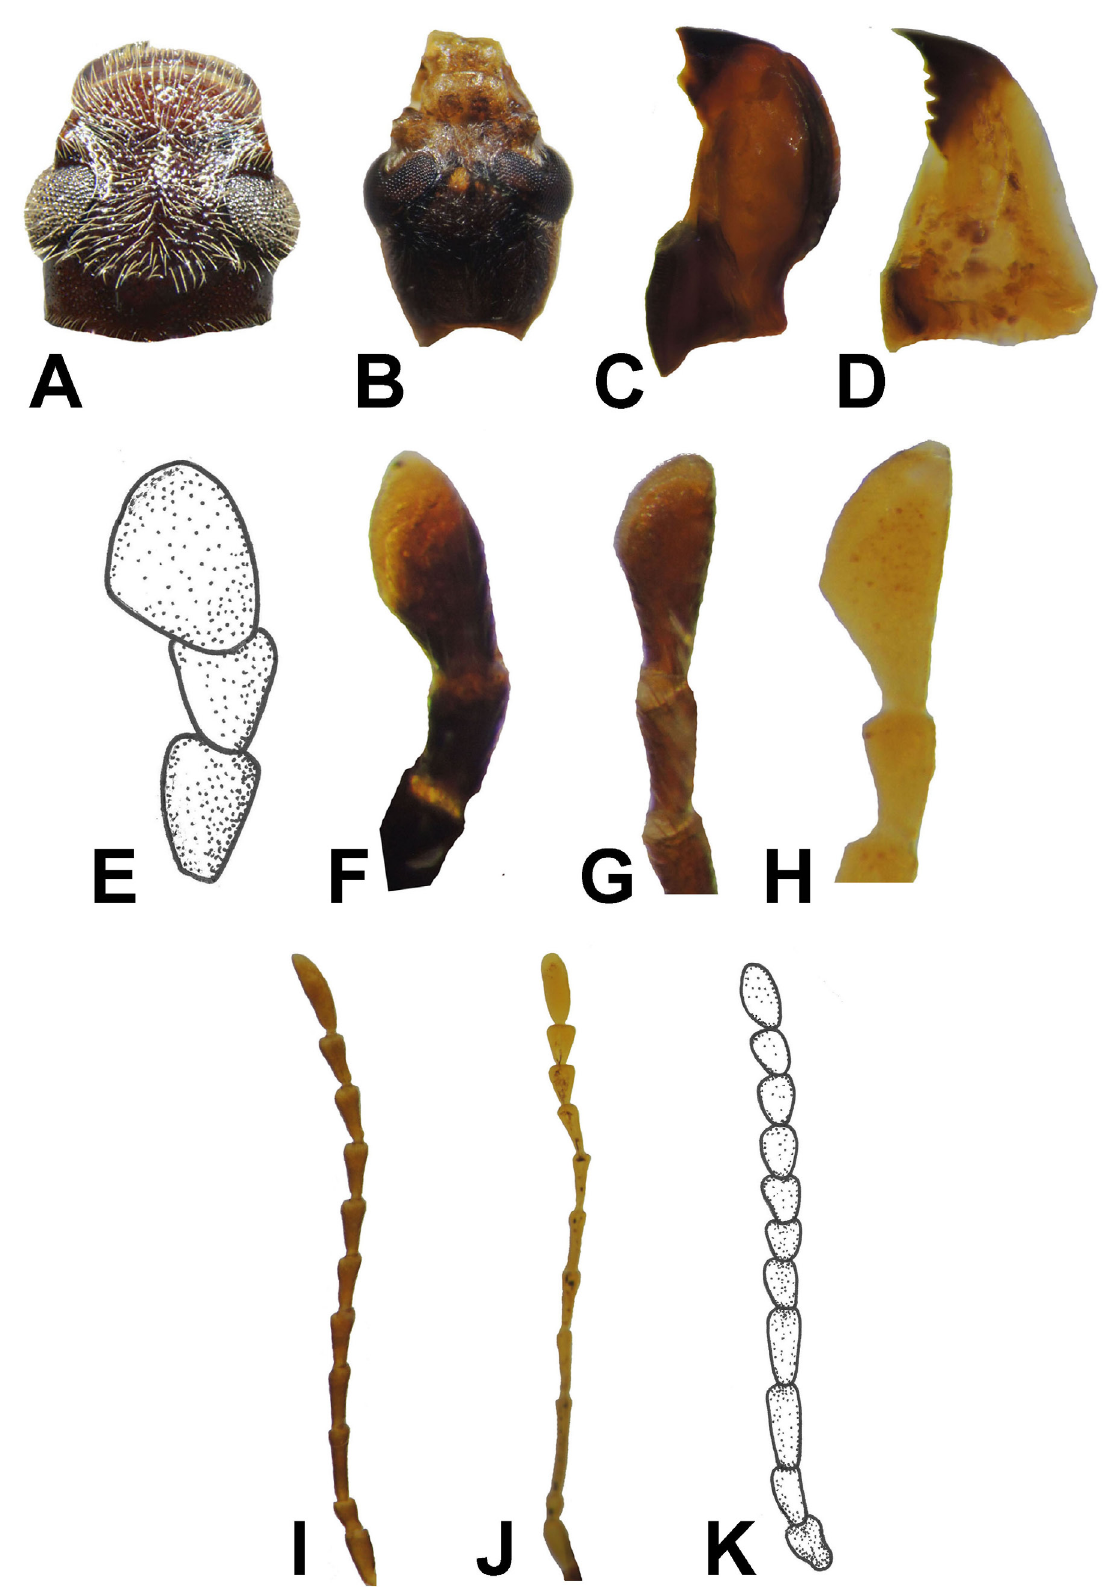
Fig. 1. Morphological characters used for the analysis. A–B . Head. C–D . Mandible. E–H . Apical maxillary palpomere. I–K .